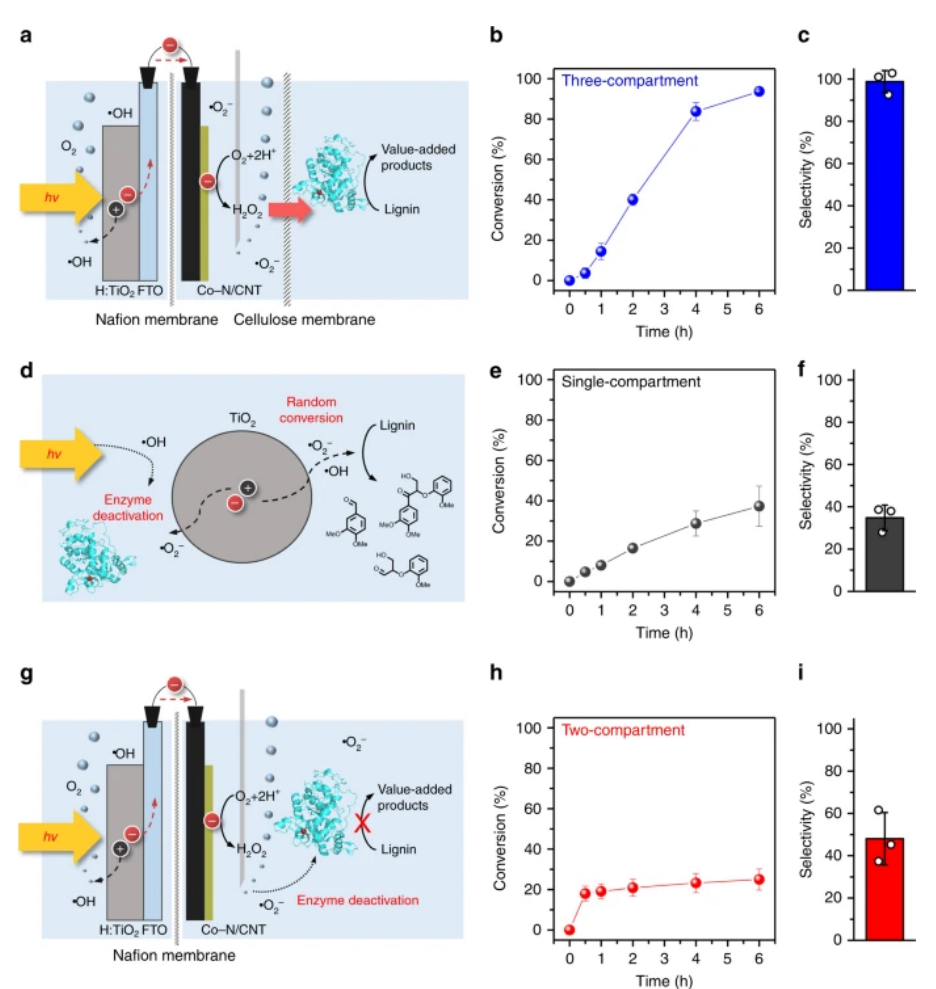
Figure 1. Schematic illustration of a photo ‐ bio ‐ electrochemical system for conversion of lignin model dimer in single ( d ), double ( g ), and three ‐ compartment ( a ) systems. The b, e, and h represent % age conversion vs time for coniferyl alcohol while c, f, i show formation of polymer yield after 6 h from three ‐ compartment photo ‐ electro ‐ biochemical system ( b , c ), single ‐ compartment powder ‐ based photo ‐ biochemical system ( e , f ), and two ‐ compartment photo ‐ electrochemicaal system ( h , i ), respectively. Standard deviation was used to show the error bars. Reprinted with permission from Ref. [54]. Copyright (2019) Springer Nature.